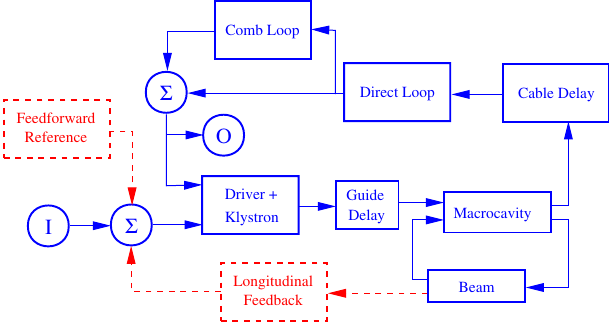
FIG. 2. (Color) Simplified system block diagram. The system transfer function is measured between I (input) and O